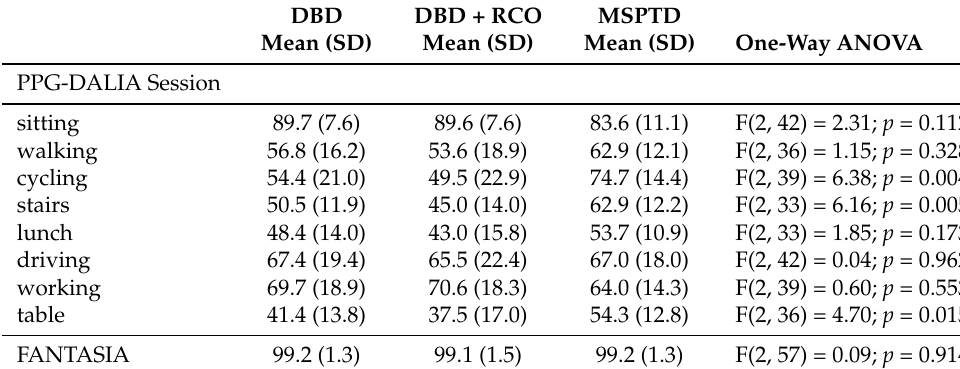
Table 1. Statistics of the F1 score for the different activities of the PPG-DALIA dataset, and on the FANTASIA dataset, for the different algorithms, and results of the one-way ANOVA to test the performance differences between the algorithms ( α =